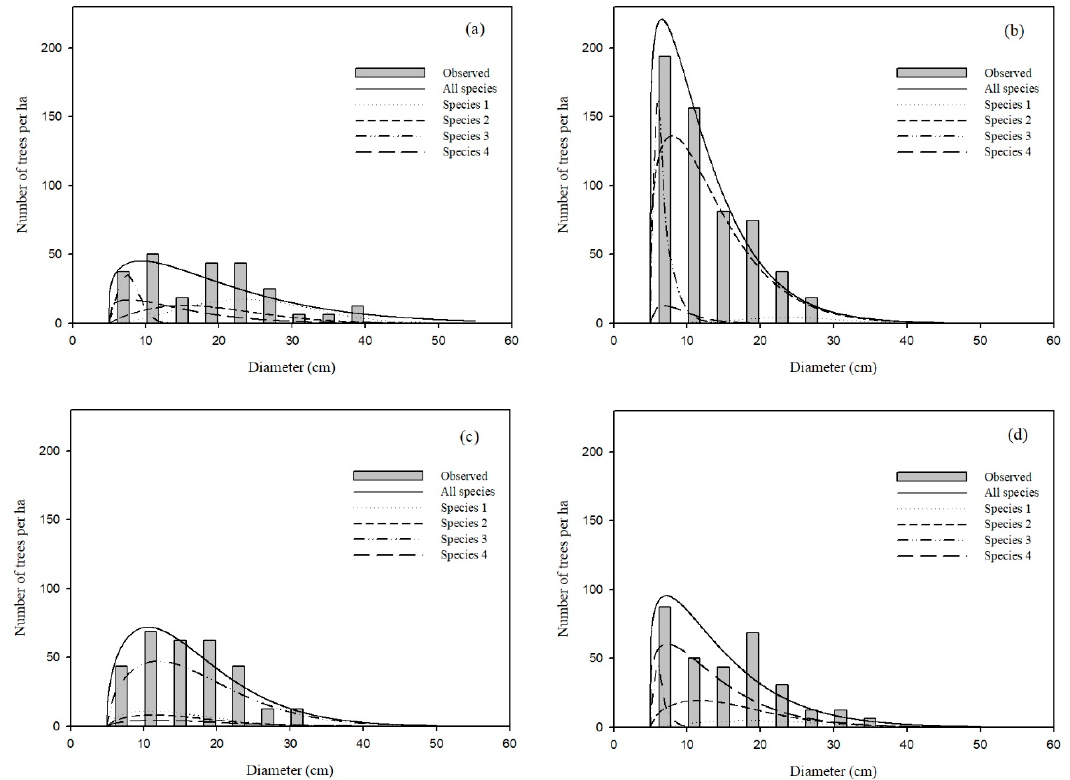
Figure 4. Comparisons of the predicted diameter distributions for each species group in four pine-oak stands. ( a ) Species 1 dominated stand (experiment Huoditang, plot 029019, n = 975 trees / ha); ( b ) species 2 dominated stand (experiment Xinjiashan, plot 049007, n = 2250 trees / ha); ( c ) species 3 dominated stand (experiment Xinjiashan, plot 050011, n = 1225 trees / ha); ( d ) species 4 dominated stand (experiment Xunyangba, plot 079015, n = 1250 trees / ha). Tree species 1 = Pinus tabulaeformis Carr.; 2 = Pinus armandii Franch.; 3 = Quercus aliena var. acuteserrata Maxim.; 4 = other species; all = all tree species. Observed = observed diameter distributions for all species (4-cm class).